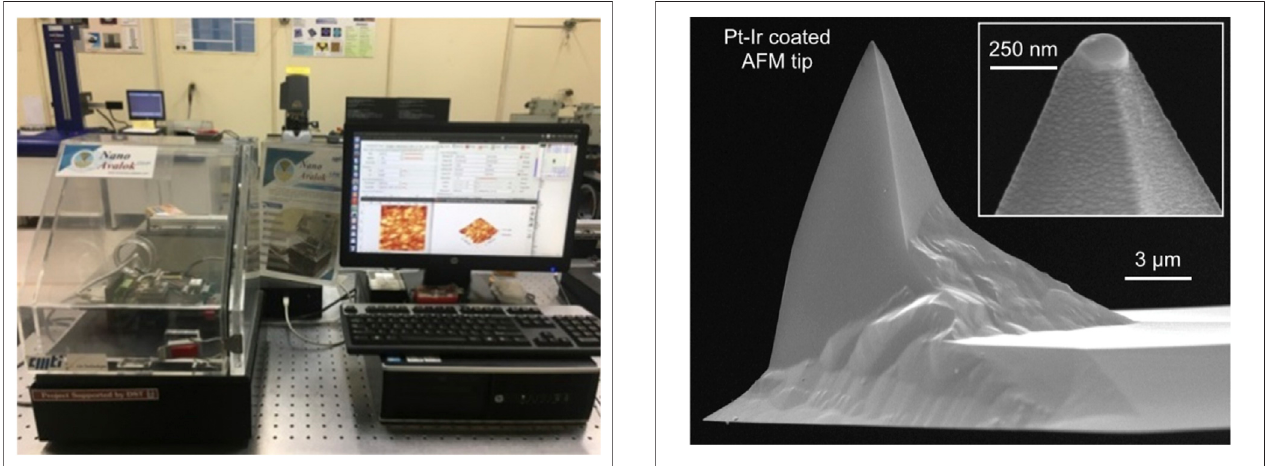
FIGURE 8 | Scanning tunneling microscope (Snv et al., 2020)